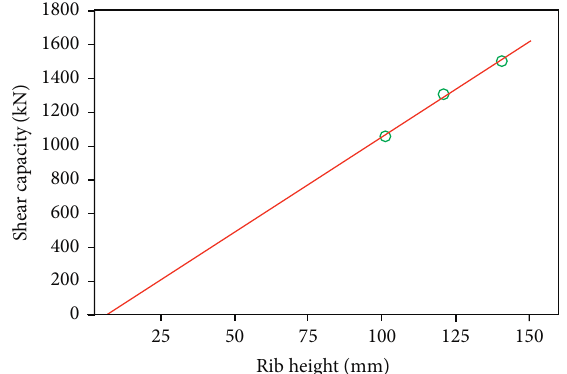
Figure 22: Linear relationship between rib height and shear